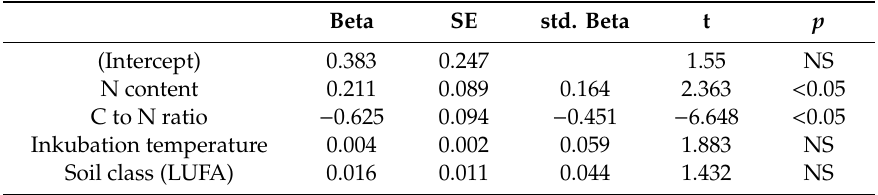
Table 2. Forward stepwise linear regression analysis of N 0 for the parameters C to N ratio, N content of the fertilizer, incubation temperature, and soil class.